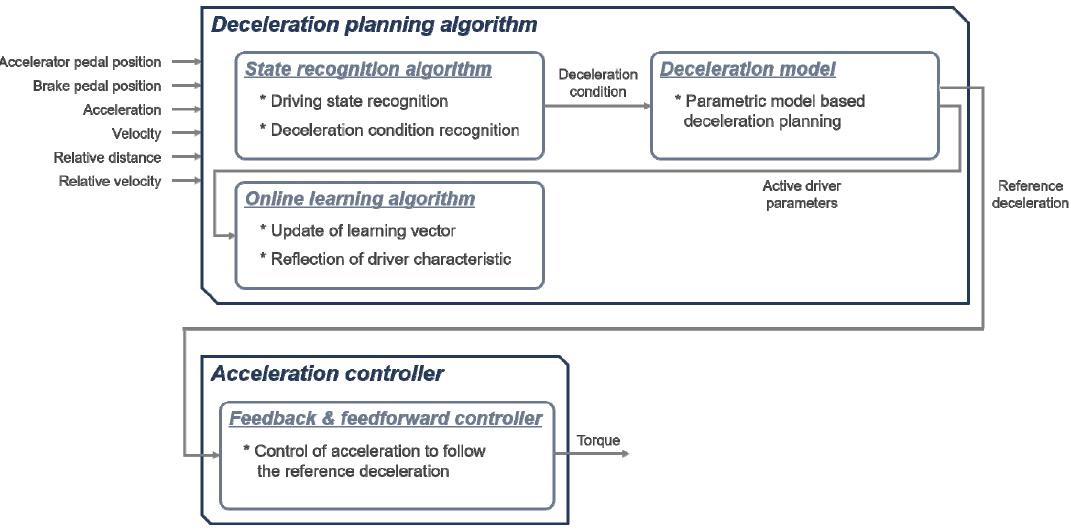
Figure 1. Overall structure of the algorithm.